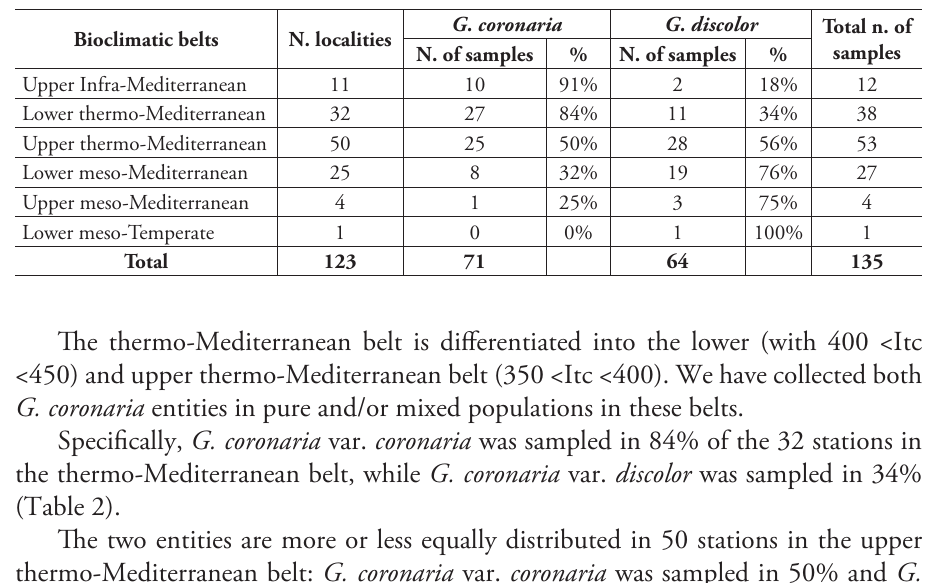
Table 2. Distribution of Glebionis coronaria and G. discolor comb. & stat. nov. selected samples studied, related to the different bioclimatic